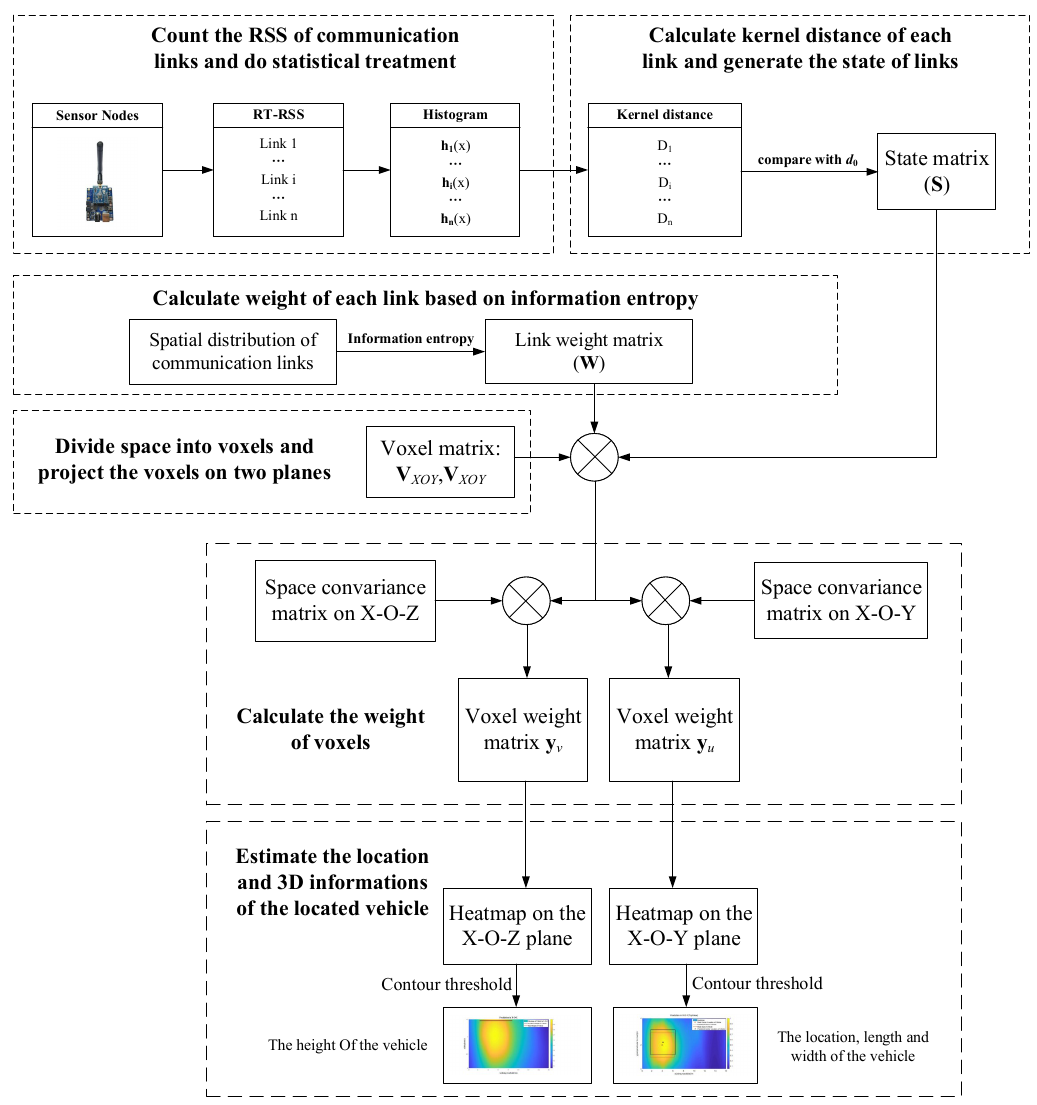
Figure 4. The flow chart of the 3D-DFL for a roadside